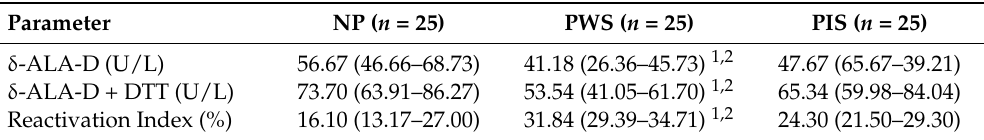
Table 4. Delta-aminolevulinate dehydratase activity and Reactivation Index in pregnant and non-pregnant